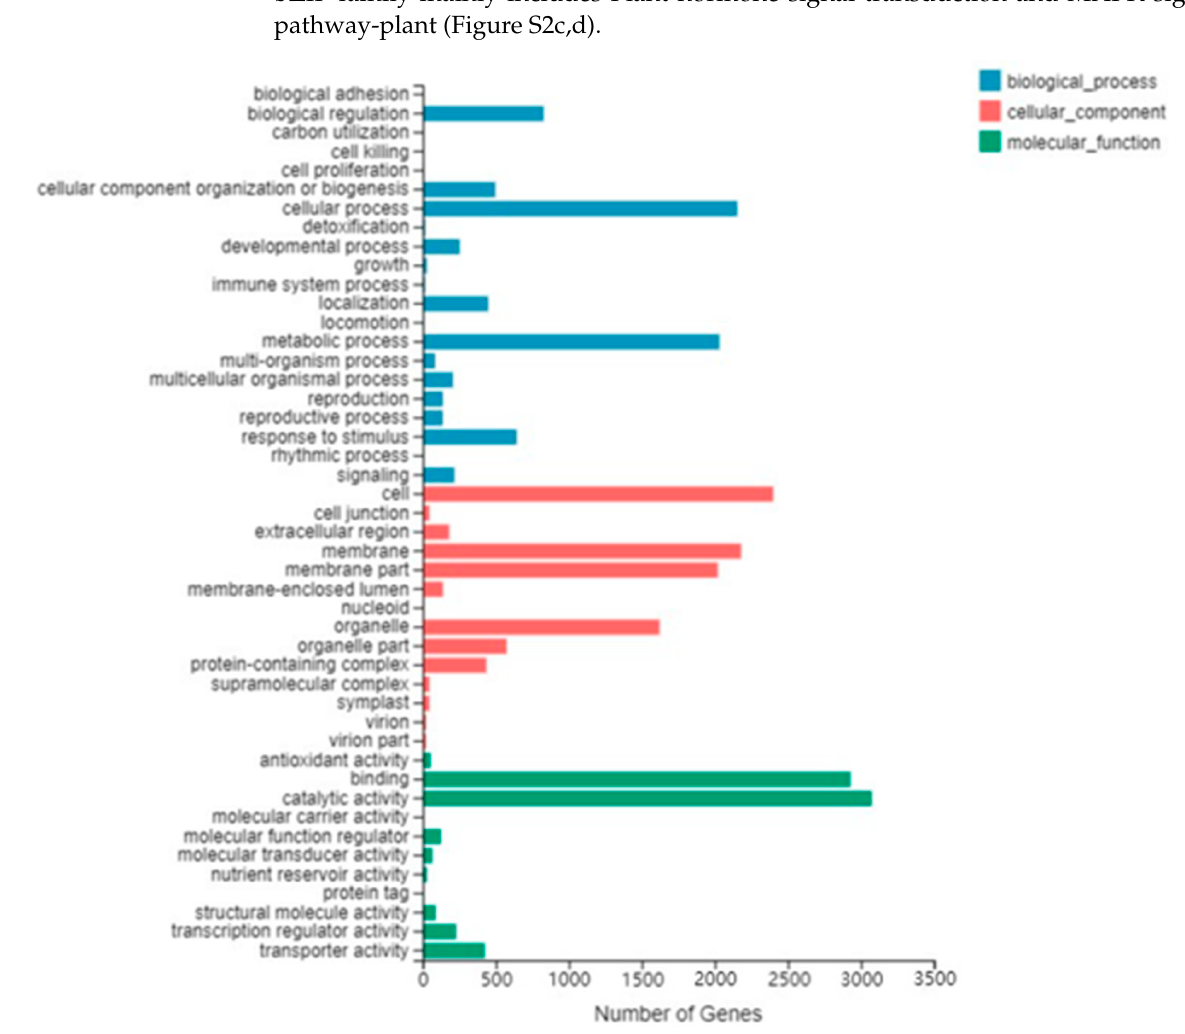
Figure 3. GO analysis of differentially expressed genes .